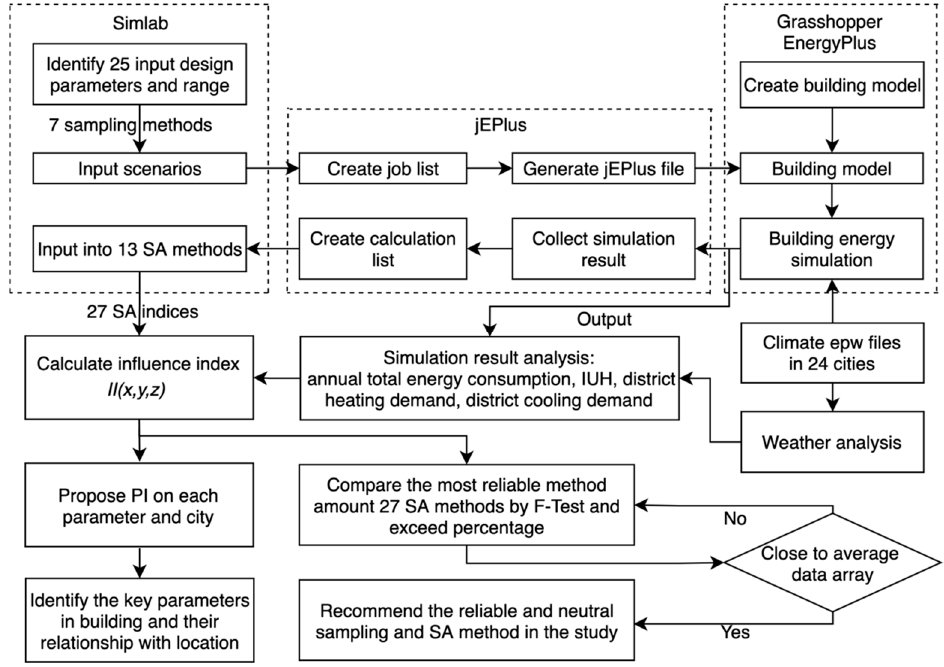
Figure 1. The research framework of this paper.